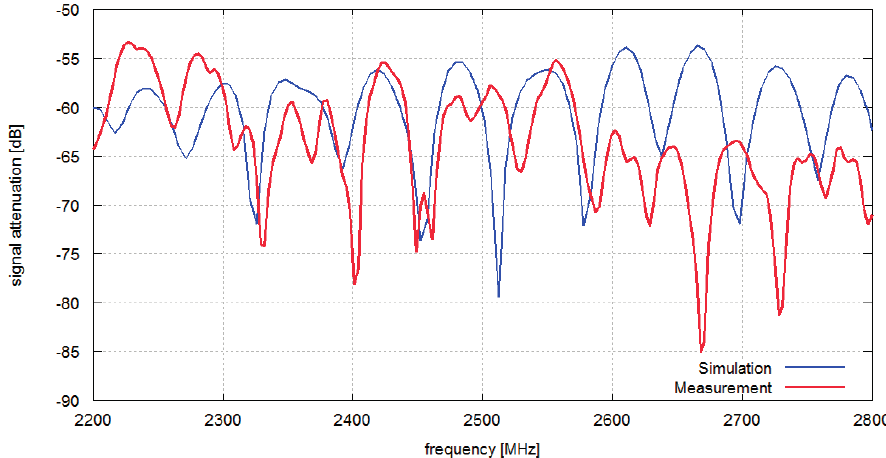
Figure 7. Measured and simulated signal attenuation vs. frequency in the indoor environment: A pair of antennas located on the chest and on an arm